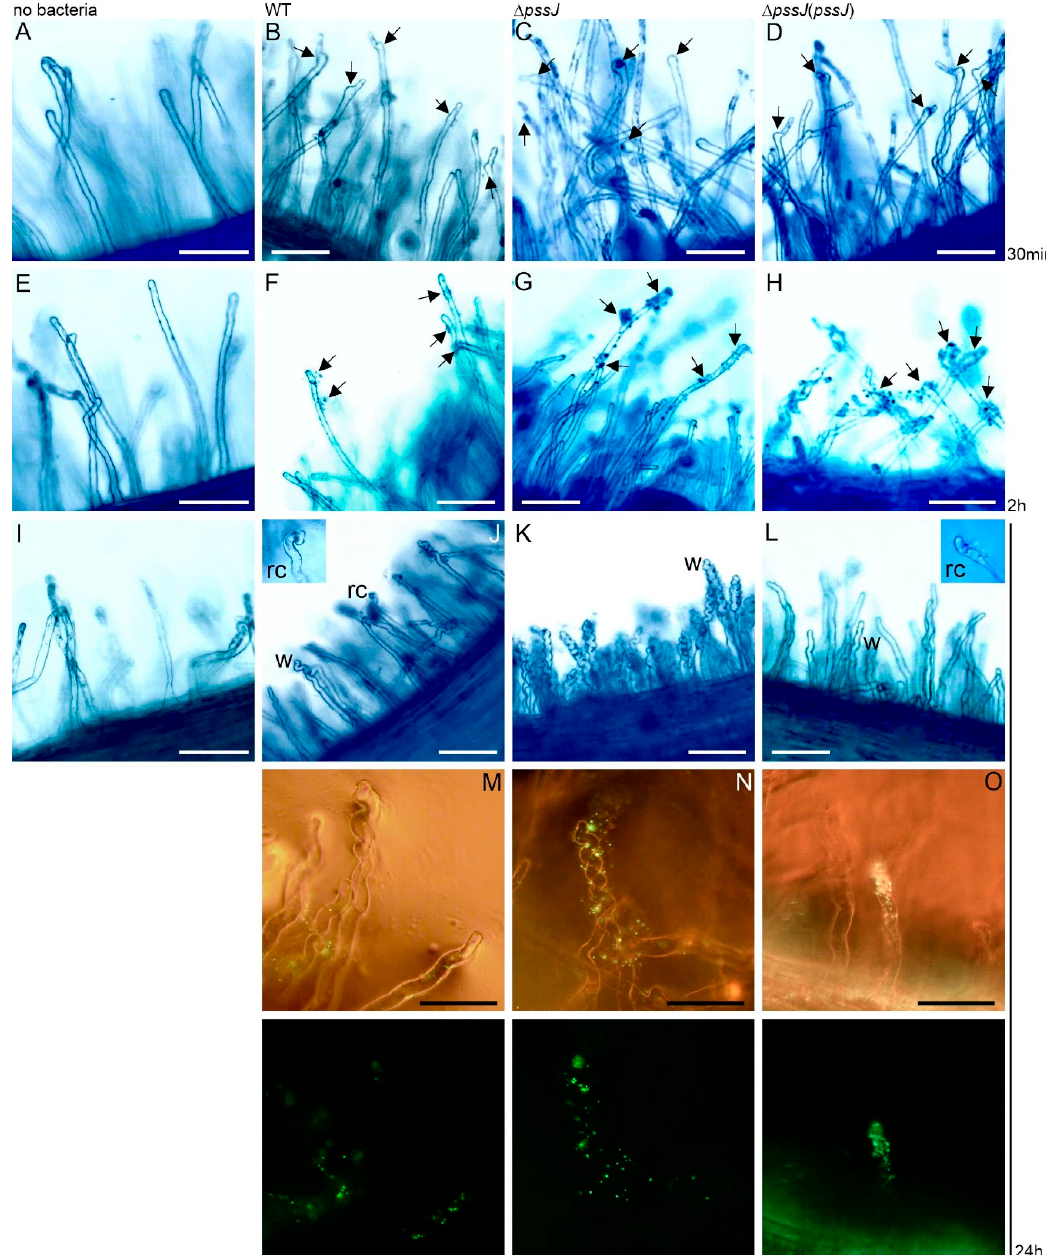
Figure 7. Light photomicrographs of root attachment and deformations induced on root hairs of Trifolium pratense L. cv. Nika after exposure to R. leguminosarum bv. trifolii TA1, the RtTA1 Δ pssJ mutant, and its complemented derivative. Control seedlings were incubated in Fåhreus medium only ( A , E , I ). The arrows point towards sites of swelling and branching observed after 30-min incubation with the bacteria ( B – D ) and sites of bacterial attachment after 2 h of incubation ( F – H ). Panels ( J – O ) show root hairs after 24 h of incubation with the bacteria. Massive root hair wiggling (w) is clearly seen in the clover roots exposed to the mutant bacteria ( K , N ). In the case of the wild type ( J , M ) and complemented strain ( L , O ), wiggles (w) and typical root hair curls (rc) were observed. Fluorescence microscopy was used to visualize the GFP-expressing cells of the analyzed strains in the last panel . For each strain, six roots were examined. Bar = 50 µ